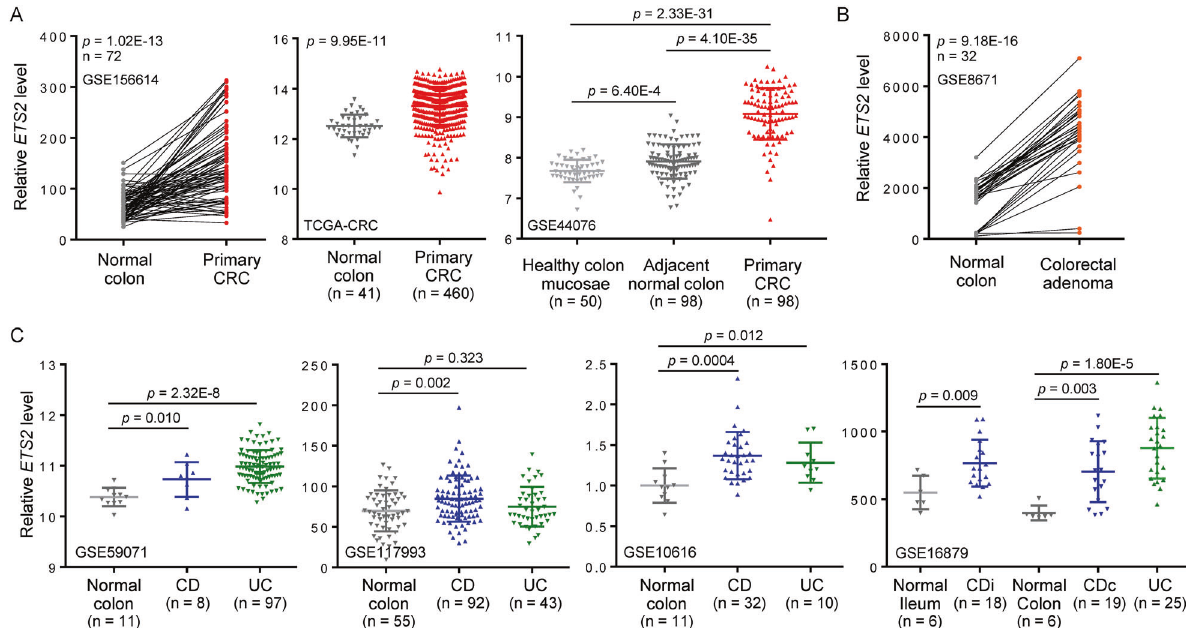
Fig. 1 The proto-oncogene ETS2 is overexpressed in CRC and IBD samples. A Relative ETS2 mRNA expression levels in three independent primary CRC datasets with adjacent normal colon or distal healthy colon mucosae as controls. B Expression of ETS2 in begin colorectal adenomas in comparison to adjacent normal colon. C Relative ETS2 mRNA expression levels in four independent IBD datasets. CD Crohn ’ s disease, UC ulcerative colitis, CDi Crohn ’ s disease in ileum, CDc Crohn ’ s disease in